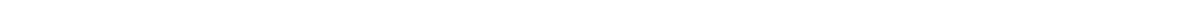
Fig. 2 The ancestral state estimates of call types and foraging categories. a The echolocation signals of bat species ( N = 183) were categorized as (i) constant frequency (CF), (ii) multi-harmonic calls (MH), (iii) frequency modulated calls dominated by the fundamental harmonic (DH), or non-laryngeal (NLE, i.e., pteropodids). Models of evolution were compared using AICc scores and the character states for ancestral call types were estimated under an equal rates model of evolution. These marginal ancestral states (i.e., the empirical Bayesian posterior probabilities) have been overlain on the phylogeny. We fi nd support for a multi-harmonic ancestral call type (Bayesian posterior probabilities: CF: < 0.001; MH: > 0.999; DH: < 0.001; MLE: < 0.001). b Bats were also categorized as (i) predatory laryngeal echolocators (ALE), (ii) phytophagous laryngeal echolocators (PLE) and (iii) phytophagous non-laryngeal echolocators (PNLE). Models of evolution were compared using AICc scores and the character states for ancestral call types were estimated under an equal rates model of evolution. These marginal ancestral states have been overlain on the phylogeny. Our results suggest that the ancestral bat was a predatory laryngeal echolocator (Bayesian posterior probabilities: ALE: > 0.999; PLE: < 0.001; PNLE: <